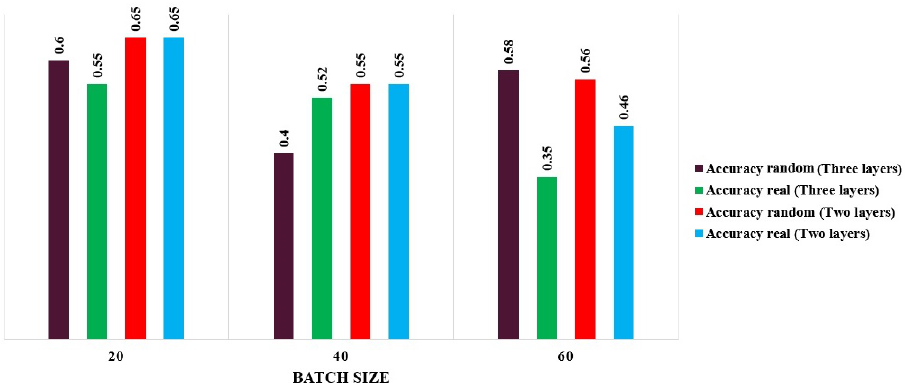
Figure 7. The discriminator’s accuracy per various batch sizes and hidden layers.